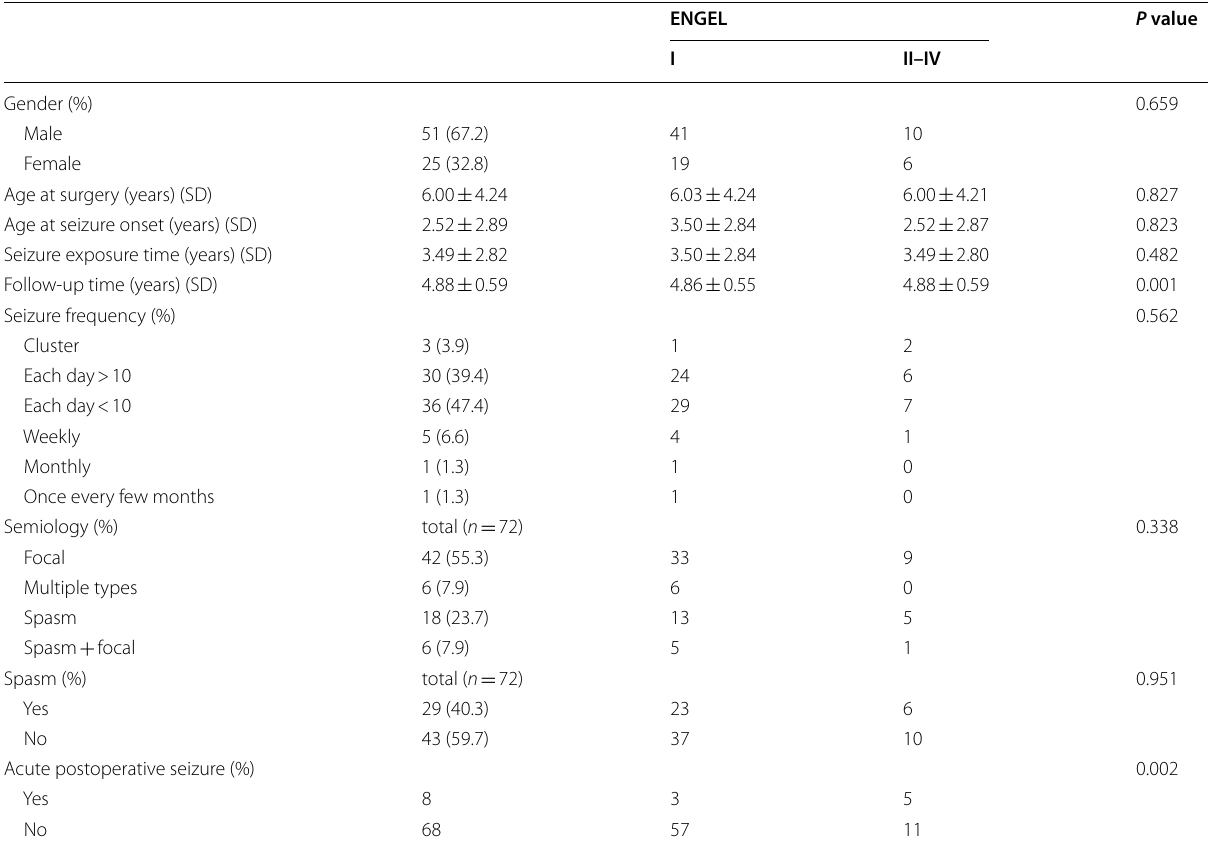
Table 1 Clinical characteristics of patients